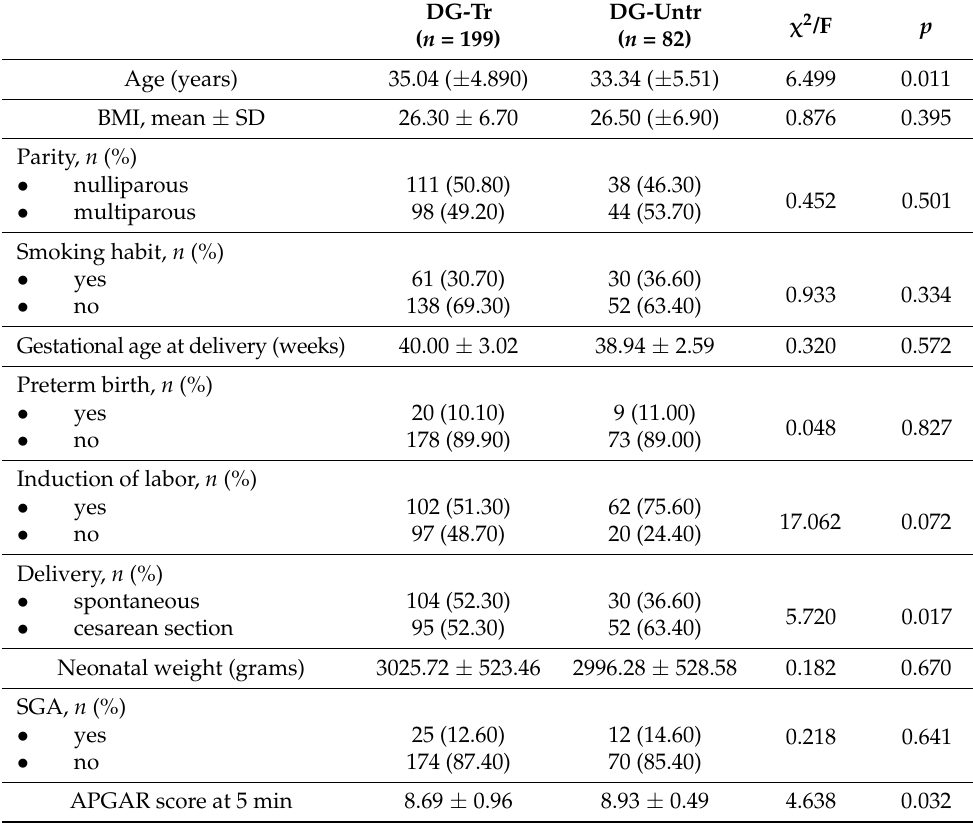
Table 2. Comparison of demographic and clinical variables of the group of pregnant women with depressive disorders receiving pharmacological treatment (DG-Tr, n = 199) vs. the group of untreated pregnant women with depressive disorders (DG-Untr, n = 82). DG-Tr DG-Untr χ 2 /F p ( n = 199) ( n = 82) Age (years) 35.04 ( ±